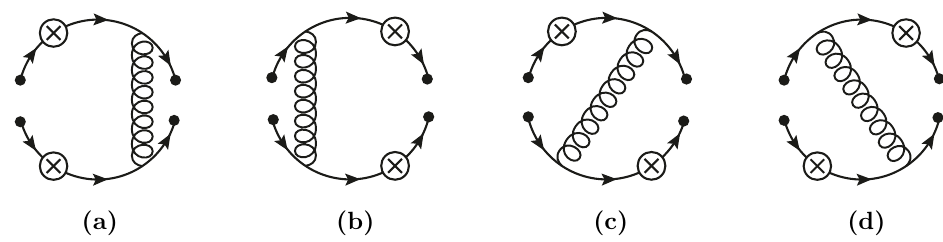
Figure 16. Feynman diagrams of the direct contribution of the four-quark condensate to the two-point Green functions. The averaging over the quark (cid:12)elds is done according to